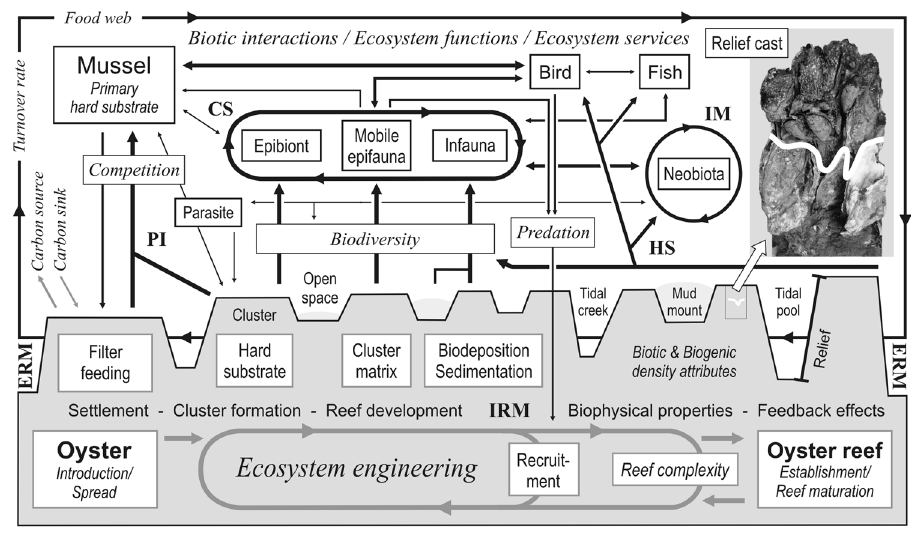
Figure 1. Ecosystem engineering conceptual framework. Effects adapted for non-native Pacific oysters modulating resident intertidal mussel beds in the Wadden Sea of the North